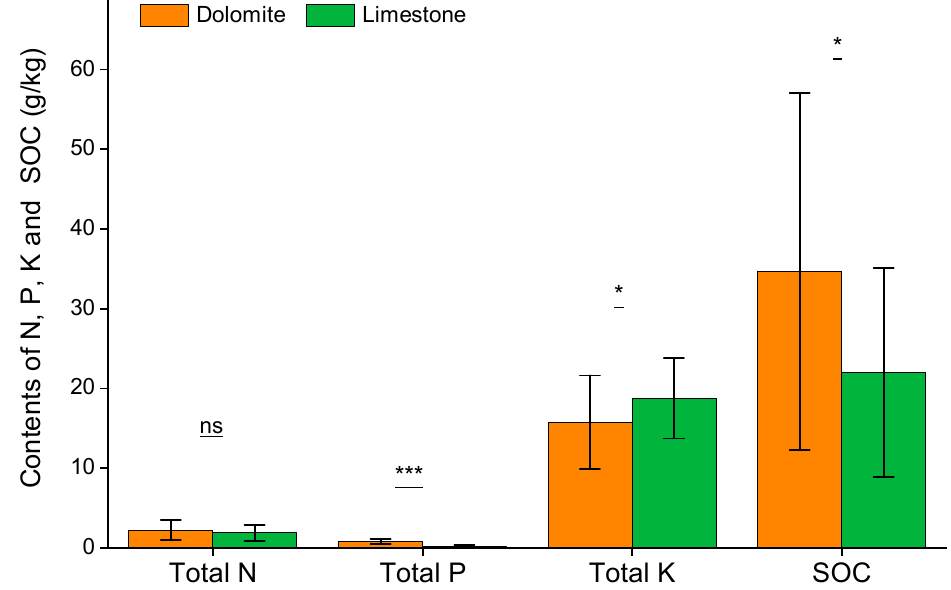
Figure 4. A comparison of total nitrogen (TN), total phosphorous (TP), total potassium (TK) and soil organic carbon (SOC) contents in soil from dolomite and limestone plots in Southwest China. Mann– Whitney U tests were used to examine differences in content of nitrogen, phosphorous, potassium and soil organic carbon in soil from 18 dolomite plots and 12 limestone plots. Each bar represents content mean ± standard deviation of the mean. The asterisks “***” and “*” represent the significance levels of 0.001 and 0.05, respectively, and “ns” represents nonsignificant levels.